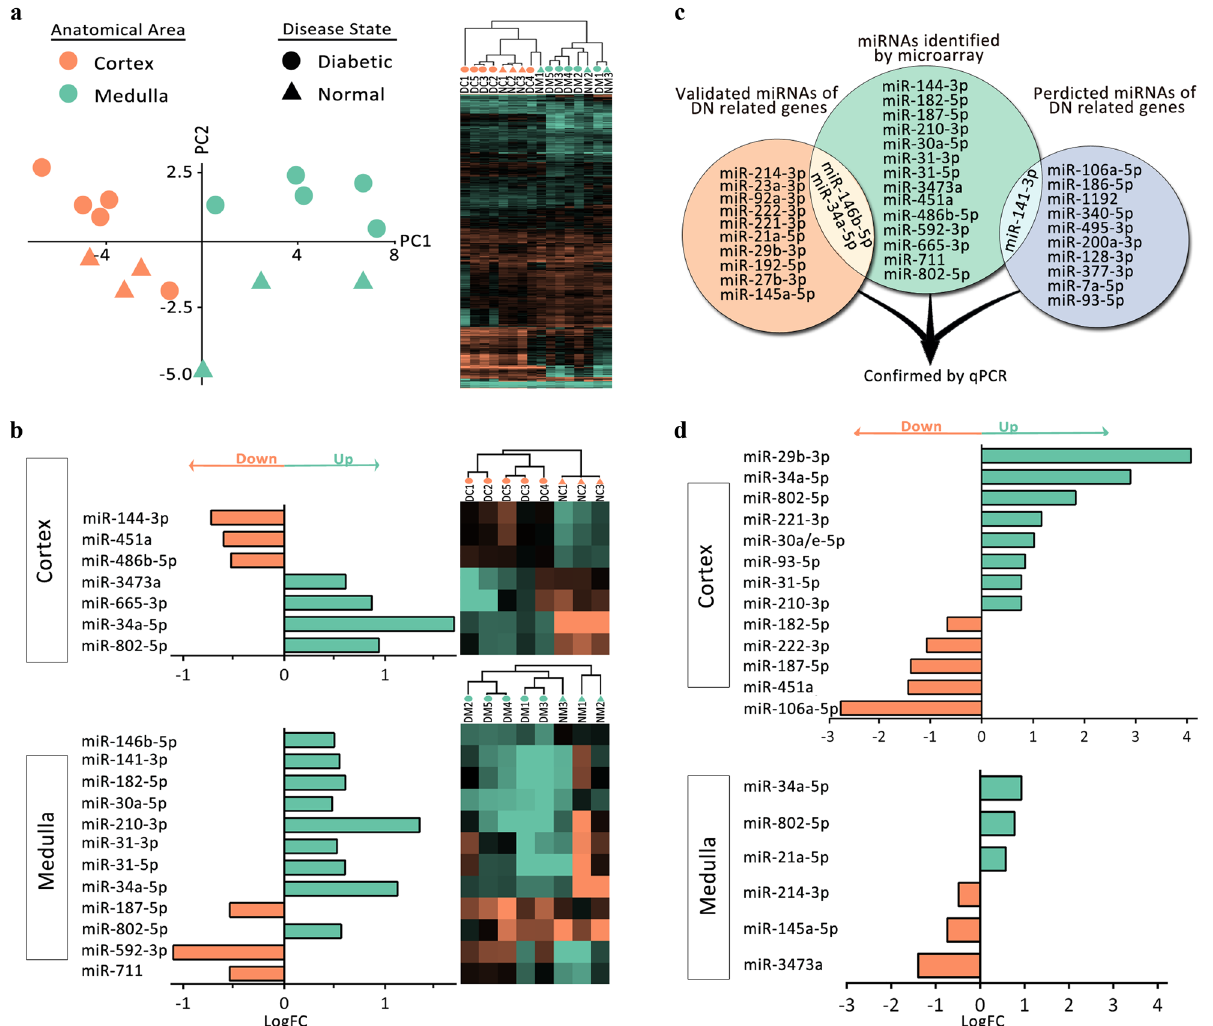
Figure 3. The kidney miRNA profile in DN. To assess microarray data quality in an unsupervised manner, principal component analysis and hierarchical clustering were performed ( a ). In microarray, miRNAs with |logFC|≥ 0.5 in cortex and medulla were determined ( b ). In addition to the miRNAs detected by microarray, some miRNAs which were experimentally shown or predicted to target DN-associated genes were selected ( c ). Among these candidates, 13 and 6 miRNAs were differentially expressed by qPCR in the cortex and medulla, respectively ( d